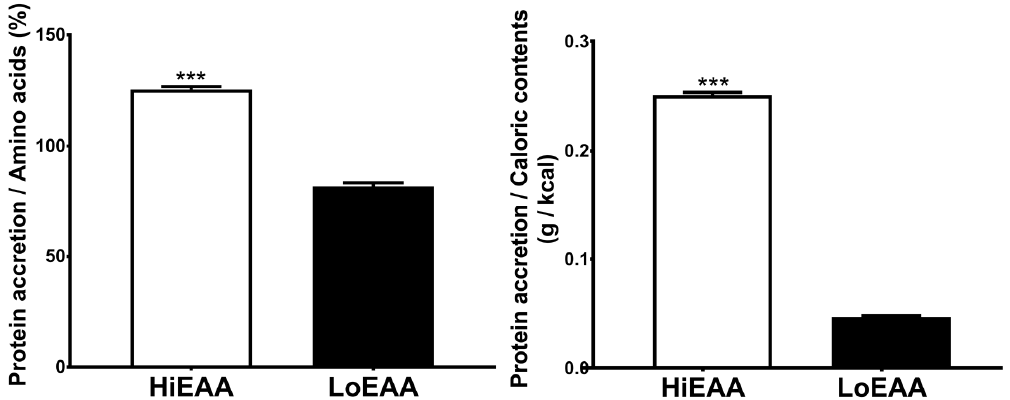
Figure 4. Net protein accretion efficiency. Efficiency was determined by dividing net protein accretion (g protein over 240 min) by either the amino acid content, multiplied by 100 (left) or by the caloric content (right) of the HiEAA or the LoEAA. ***Significantly different from the LoEAA, p < 0.001. content (right) of the HiEAA or the LoEAA. *** Significantly di ff erent from the LoEAA, p < 0.001. Values ( n = 7) are expressed as mean ± SEM. Values ( n = 7) are expressed as mean ± SEM.